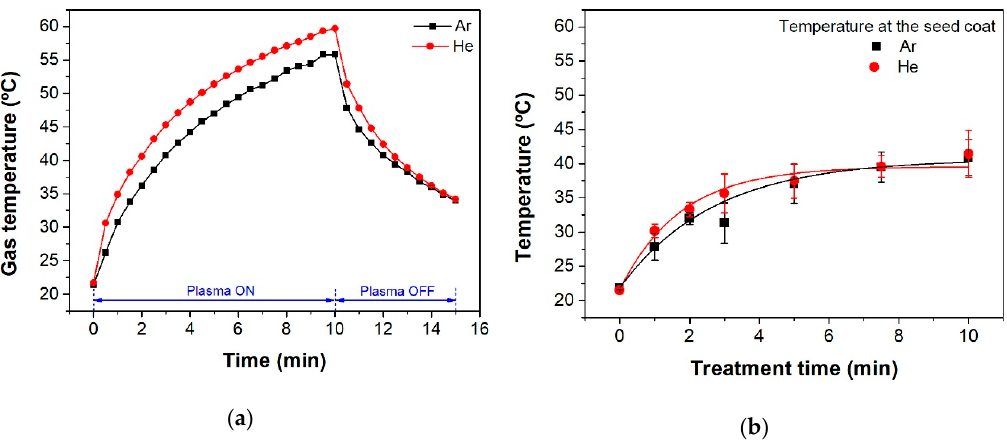
Figure 5. Temperature measured ( a ) inside the reactor for both gases during 10 min of plasma on and cooling process after plasma is turned off. ( b ) Temperature at the seed coat of wheat treated for treatment times varying from 1 to 10 min using an argon (black) and helium (red) discharge.